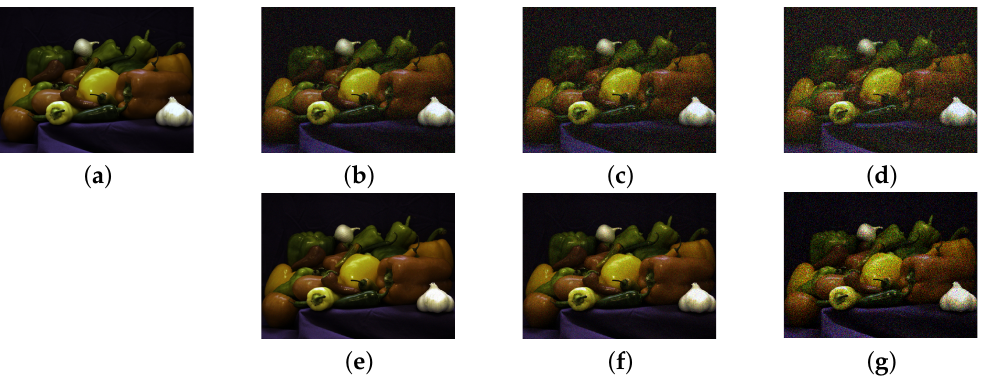
Figure 1. Example of several noise levels of different types. ( a ) Classical peppers image from the default image dataset of MatLab. ( b – d ) peppers image affected by Gaussian noise of level 0.1, 0.4, and 0.7, respectively. ( e – g ) pepper image with different Poisson noise levels. The Poisson noise has been added via the MatLab function imnoise